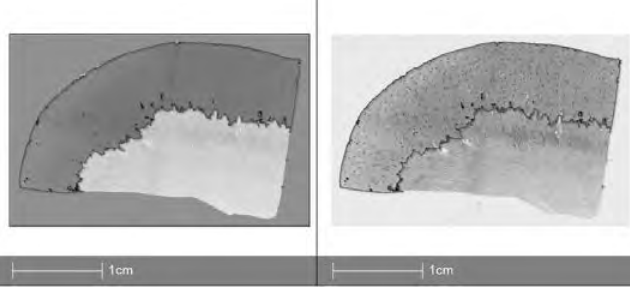
Figure 1: cortex medulla differenciation by